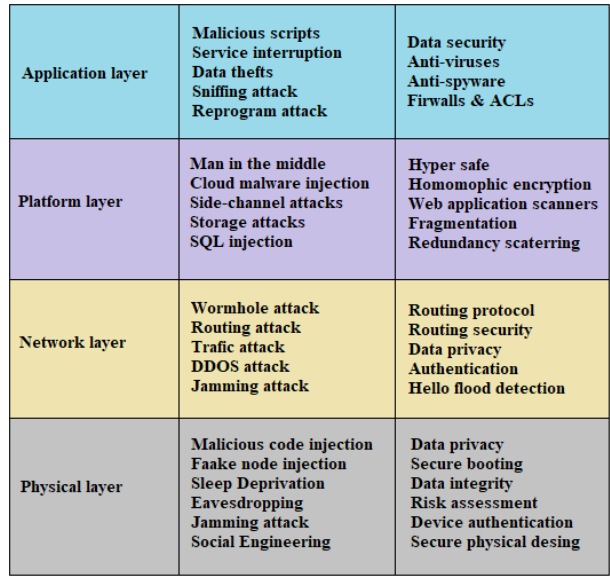
Figure 2 . Security threats in IoT architecture